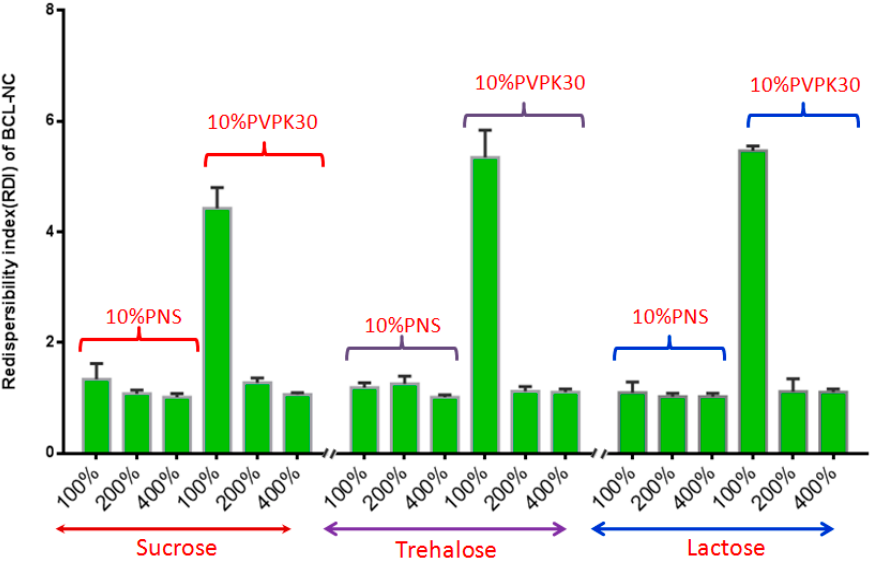
Figure 8. Redispersibility of BCL-NS/10% PNS and BCL-NS/10% PVPK30 combined with different concentrations of matrix formers during spray-drying (mean ± S.D., n = 3).